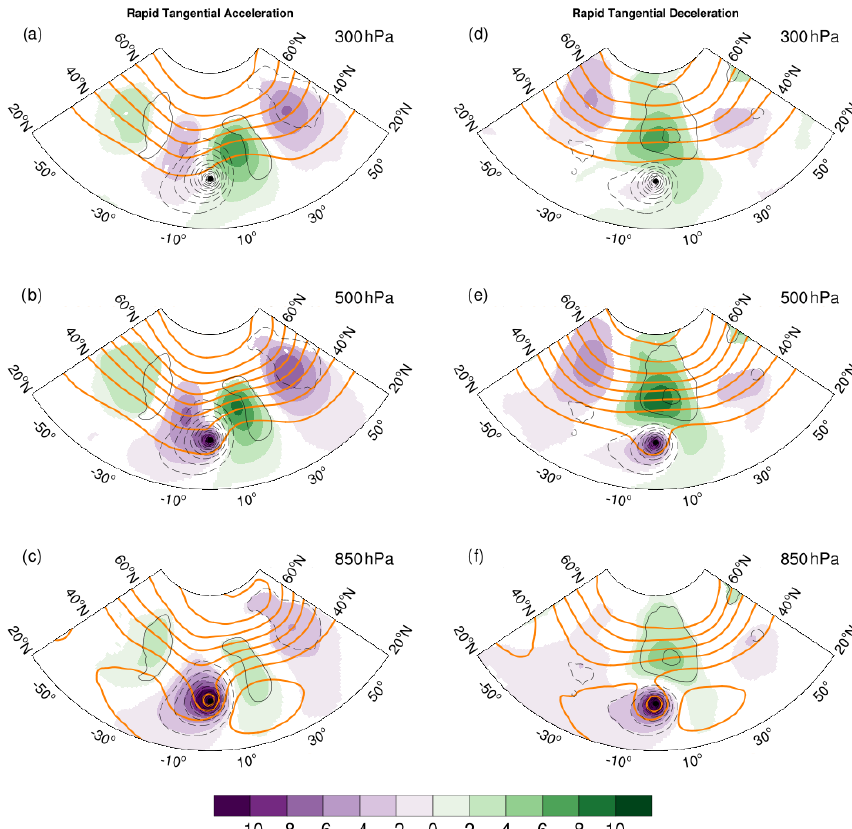
Figure 3. Storm-relative composite average geopotential heights (thick orange lines) and anomalies (color shaded) for all TCs located in the latitude bin 30–40 ◦ N over the Atlantic. The composite fields are shown for three levels – 300, 500, and 850hPa. In each panel, the composite 1000hPa anomalous geopotential is shown using thin black contours. All anomalies are defined relative to a long-term synoptic climatology. The contour intervals are 12, 6, and 3dam for the three levels, respectively. The shading interval in decameters for the 300hPa anomaly fields is shown in the label bar. It is half of the value for the other two levels. Panels (a) – (c) show rapid tangential acceleration, and panels (d) – (f) show rapid tangential